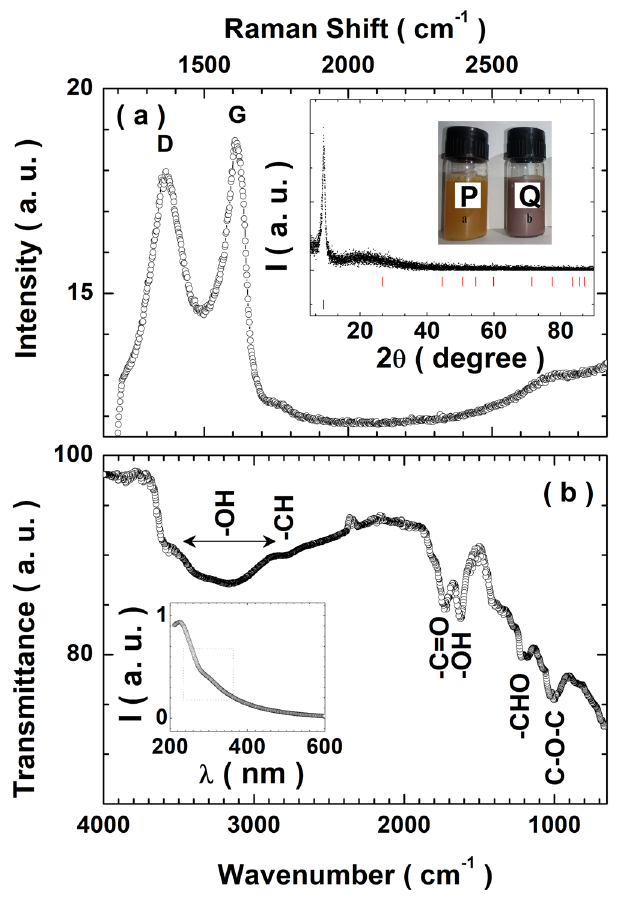
Figure 2. ( a ) Raman spectra for the drop casted film of the as grown GO sample. The D and G peaks are marked. The slight hump in the wavenumber range 2550–2780 cm − 1 corresponds to the 2D peak. The inset in panel (a) shows the powder x-ray diffraction data for the dried as grown sample. It shows the characteristic peak corresponding to GO. The bottle marked P shows the dispersed GO sample whereas the bottle marked Q contains the reaction mixture just prior to adding H 2 O 2 to terminate the reaction used in our process. ( b ) FTIR spectra for the dried as grown GO sample obtained in the transmittance mode. The bands and dips corresponding to various functional groups are marked. The inset in panel (b) shows the UV-Vis spectra for the as grown GO sample dispersed in de-ionised water. The region enclosed by the square (dotted lines) is characteristic feature corresponding to